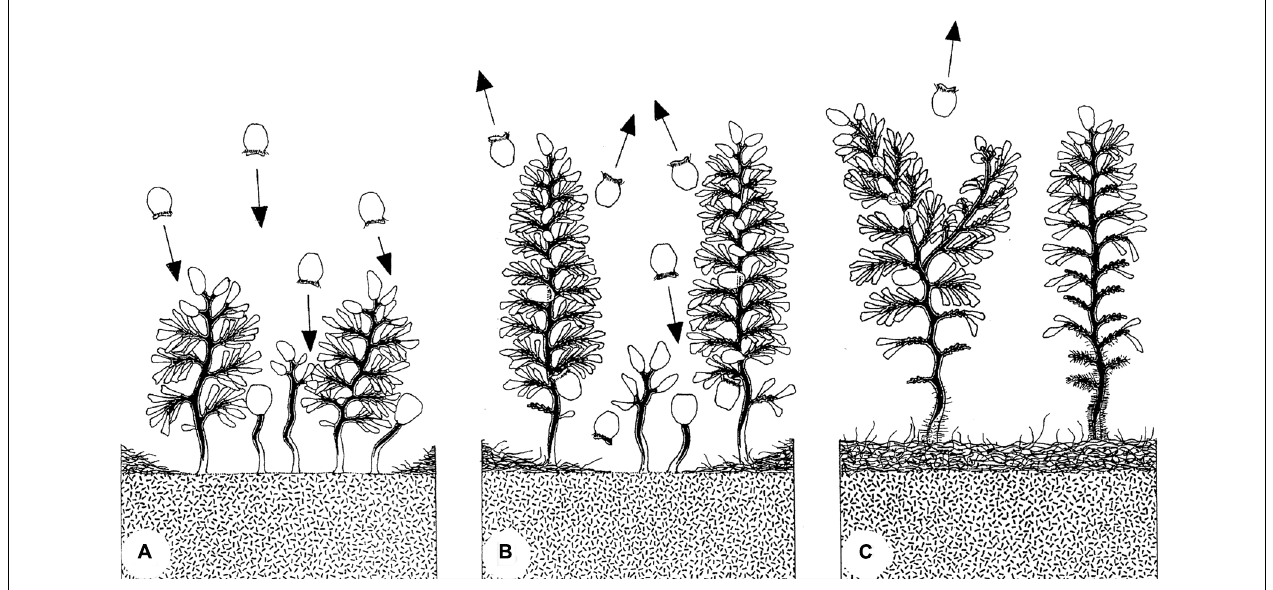
FIGURE 9 | Evolution of a patch of Zoothamnium niveum colony. The swarmers colonize a disturbed area (A) .The settled colonies grow and start releasing new swarmers during a maturation phase (B) . Finally, the colonies